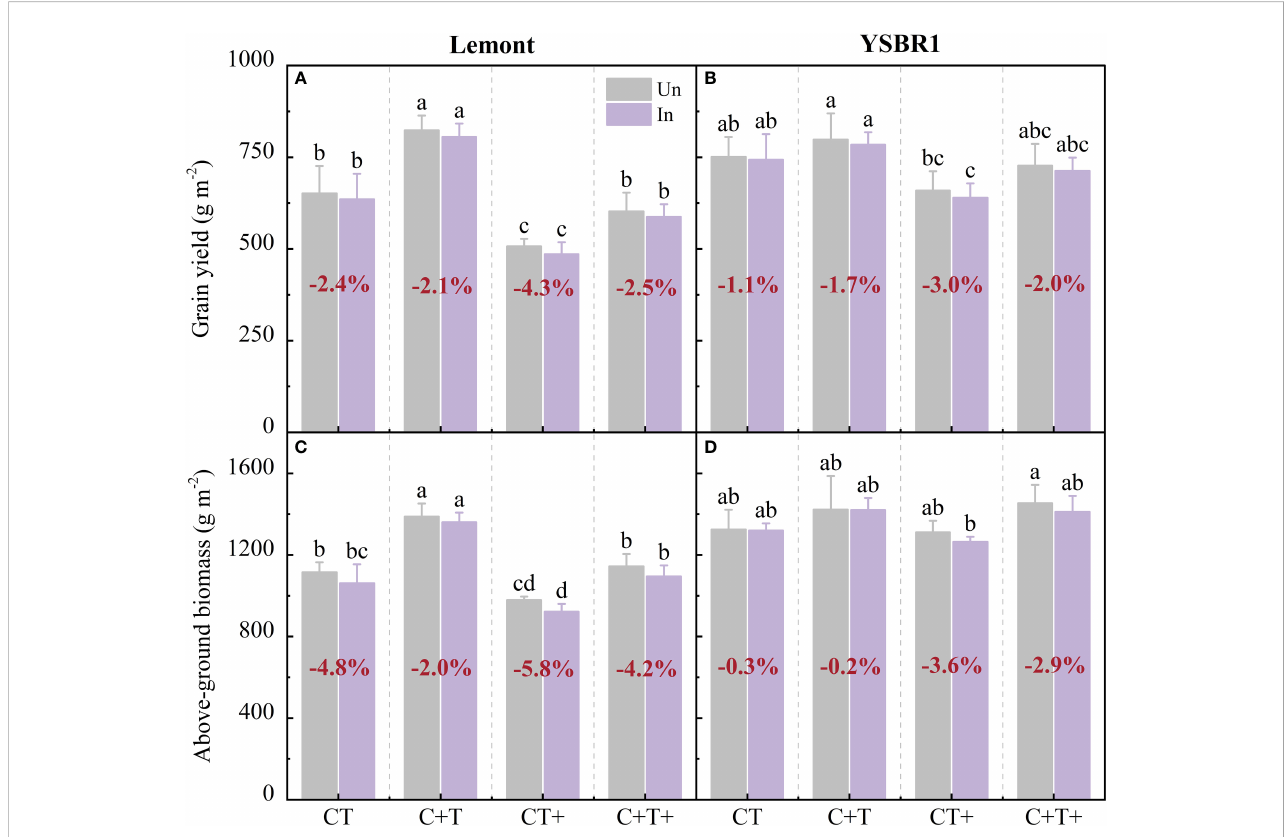
FIGURE 4 Grain yield and above-ground biomass at maturity for inoculation (In) and uninoculation (Un) of cvs Lemont (A, C) and YSBR1 (B, D) under ambient condition (CT), elevated CO 2 (C+T), elevated temperature (CT+) and the combination of elevated CO 2 and elevated temperature (C+T+) in the T-FACE experiments of 2021. Different letters above the bars in the same time of each parameter indicate statistically signi fi cant differences ( p < 0.05). The bold number in red for each treatment in (A, B) is the average reduced ratio in grain yield of inoculated to uninoculated plants, and in (C, D) is the average reduced ratio in above-ground biomass of inoculated to uninoculated